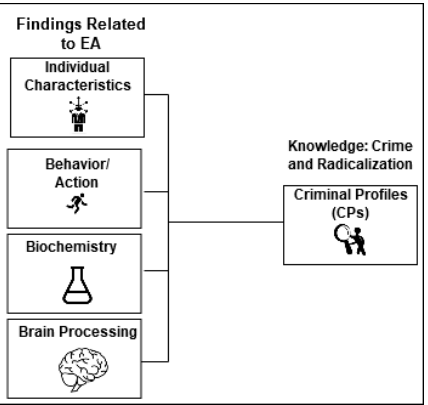
Figure 1. Ontology idea based on combining the four IBBB’s (individual characteristics (world level 2 or 3), behavior (level 1 or 3), biochemistry (level 1), brain processing (level 2)) and CPs (criminal profiles) (level